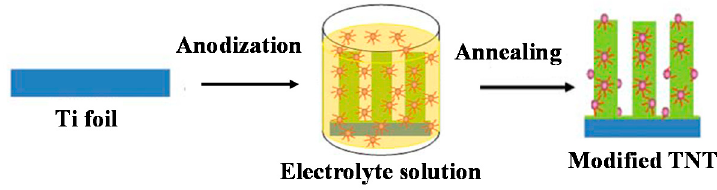
Figure 8. Schematic diagram of the one ‐ step fabrication of modified TNTs by anodization.